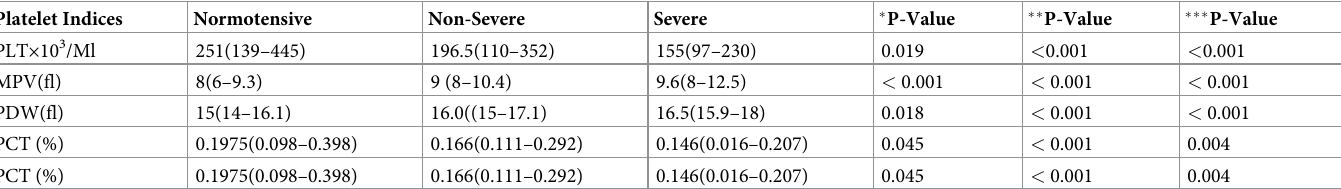
Table 4. Pairwise comparisons of platelet indices among normotensive, non-severe, and severe pre-eclamptic pregnant women in NEMMCSH from January 1 to April 3, 2019(post hock). Platelet